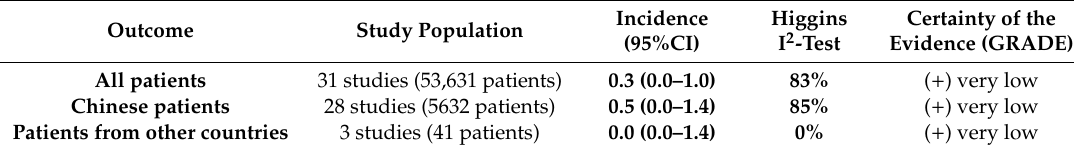
Table 2. Summary of findings (SOF) table for all-cause